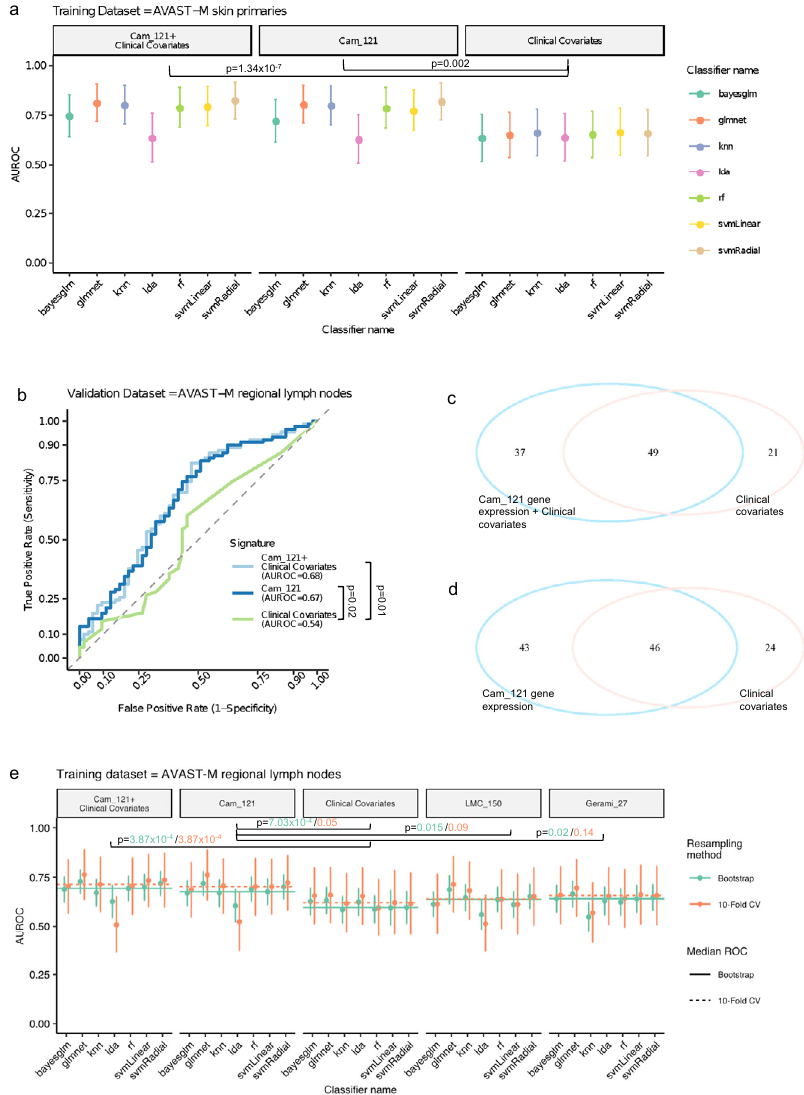
Fig. 3 The Cam_121 gene expression signature is predictive of metastases across multiple machine learning classi fi cation models and in an internal validation dataset ( n = 143). a Plot showing the mean±standard deviation of area under the ROC curve (AUROC) predicted by different classi fi cation models when trained using tenfold cross validation (CV; repeats = 1000) on the AVAST-M primary melanoma dataset ( n = 194). The features used for training each classi fi cation model are indicated on the top grey panel. Within each panel, seven different machine learning classi fi ers were trained to predict metastases. Statistical comparison using one-sided two-sample Welch t tests are indicated (see also Supplementary Table S2a). b Area under the ROC curve plots, showing, for the best performing classi fi cation model selected in each panel of a , its performance on an entirely separate AVAST-M lymph node validation dataset ( n = 143). The one-sided DeLong ’ s test p value is reported for each comparison (see also Supplementary Table S2b). c , d Venn diagrams comparing the number of correctly predicted relapse outcomes (yes/no) of 143 patients from the models described in b . c Venn diagram showing the number of correctly predicted relapse outcomes speci fi c to or common between “ Cam_121 + clinical covariates ” (blue) vs “ Clinical covariates ” (pink). d Venn diagram showing the number of correctly predicted relapse outcomes speci fi c to or common between “ Cam_121 ” (blue) and “ clinical covariates ” alone (pink). Out of a total of 143 patients, 30 were wrongly predicted by both the models in c and 36 were wrongly predicted by both the models in d . e Plot showing the performance of different classi fi cation models in predicting metastases in terms of AUROC (mean±standard deviation) when trained on the AVAST-M lymph node dataset ( n = 143). Within each panel, 14 different machine learning classi fi ers were trained to predict metastases: seven using tenfold CV (repeats = 1000) and seven using bootstrap resampling method (repeats = 1000). The two horizontal lines indicated within each panel denote the median AUROC of these seven classi fi ers, respectively. Statistical comparison using one-sided two-sample Welch t tests are indicated (bootstrap in green and tenfold CV in orange), see also Supplementary Tables S2c-d. Gerami_27, LMC_150: Leeds Melanoma Cohort 150 gene signature. See “ Methods ” section “ Machine learning analysis “ for details about the classi fi cation algorithms. Source data are provided as a Source data fi We undertook further multivariate Cox regression analyses for depleted tumour with worse clinical outcomes . In order to all protein-coding genes in this dataset ( n = 19,427) and found no single gene was signi fi cantly associated with either PFS or identify the biological processes re fl ected by the signature, we ran OS after correcting for multiple testing ( p value < 0.05) (Supple- pre-ranked gene set enrichment analyses on genes ordered by mentary Data 2 and Supplementary Data 3). their shrunken log-fold change from the covariate-corrected